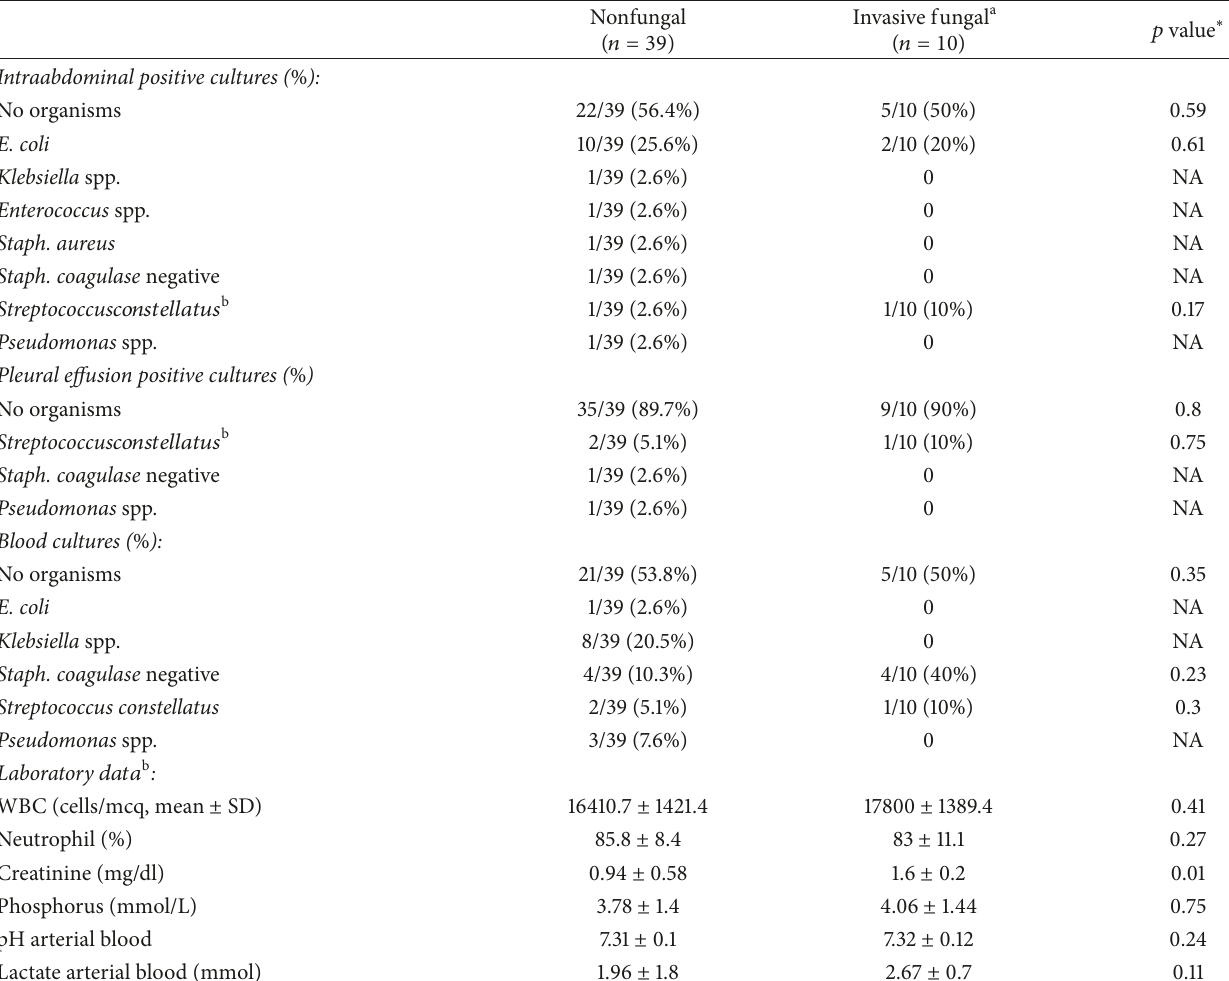
Table 3: Microbiological data (from intraabdominal fluid, blood, and pleural effusions) and other laboratory parameters of the Group 2 patients during their ICU stay.